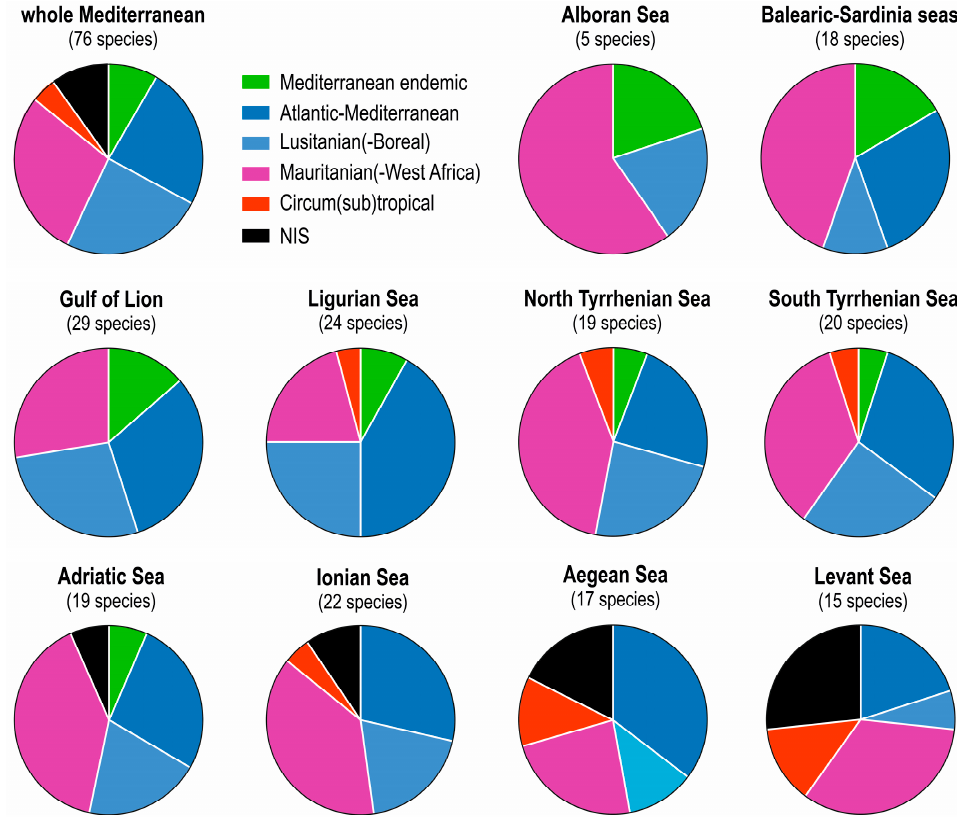
Figure 4. Chorological spectra of cave decapods in the Mediterranean Sea as a whole and in ten marine sectors. NIS = non-indigenous species.